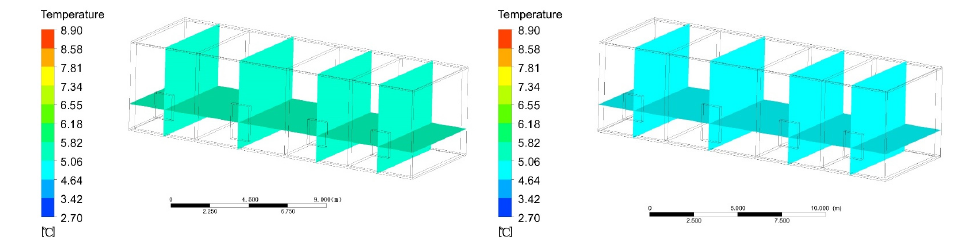
Figure 6. ( a ) At 9:00 a.m. the temperature of the ordinary heating (with WSR). ( b ) At 11:00 a.m. the temperature of the ordinary heating (with WSR). ( c ) At 1:00 p.m. the temperature of the ordinary heating (with WSR). ( d ) At 3:00 p.m. the temperature of the ordinary heating (with WSR). ( e ) At 5:00 p.m. the temperature of the ordinary heating (with WSR). ( f ) At 7:00 p.m. the temperature of the ordinary heating (withWSR).